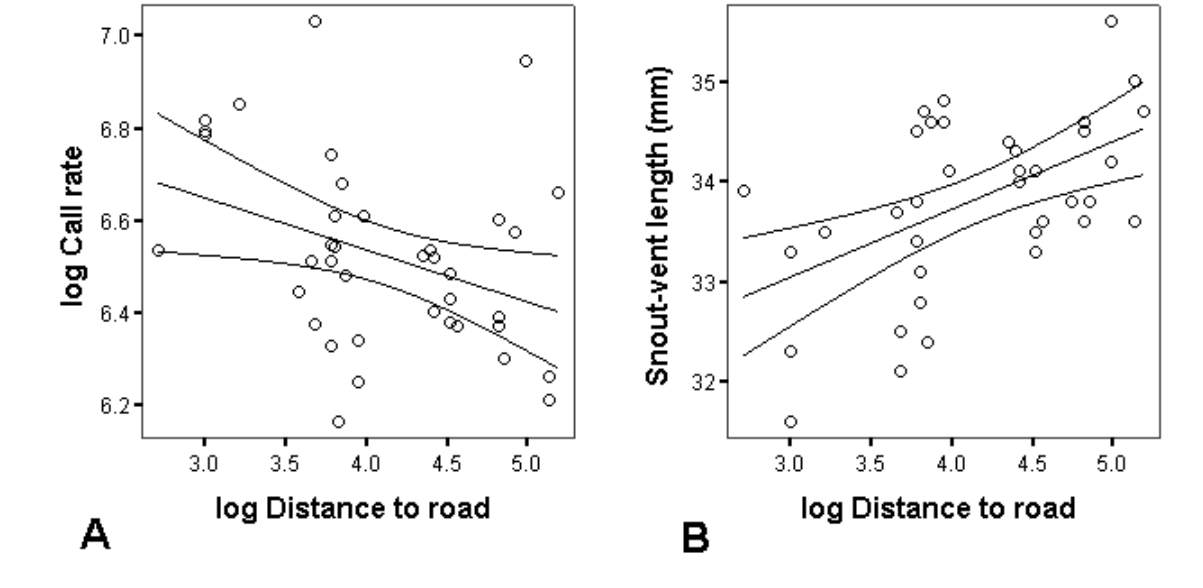
Fig. 3 . The relationship between (A) call rate and (B) body size, and perpendicular distance to the road for L. rheocola across the entire upstream Streets Creek transect. Graphs show the regression line with upper and lower 95% confidence limits. The x-axis shows log of distance from the road; the range of the untransformed data is 15-180